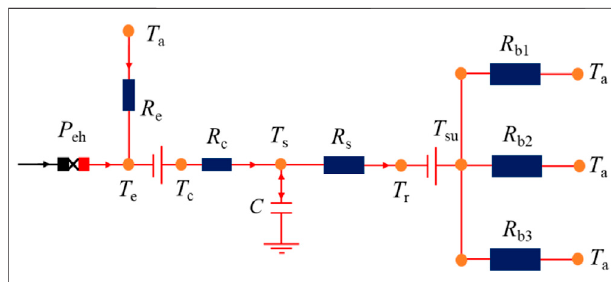
FIGURE 3 | Heat current model of the heat pump – thermal energy storage – heat